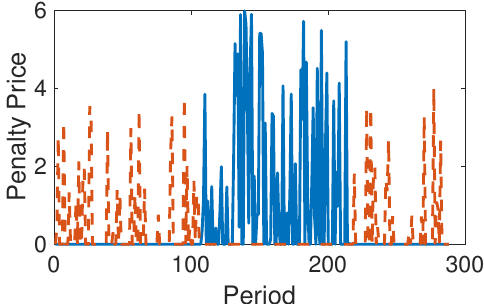
Figure 4. The solid line shows the total penalty price ($ per MW) for drawing power and the broken line shows the total penalty price ($ per MW) for injecting